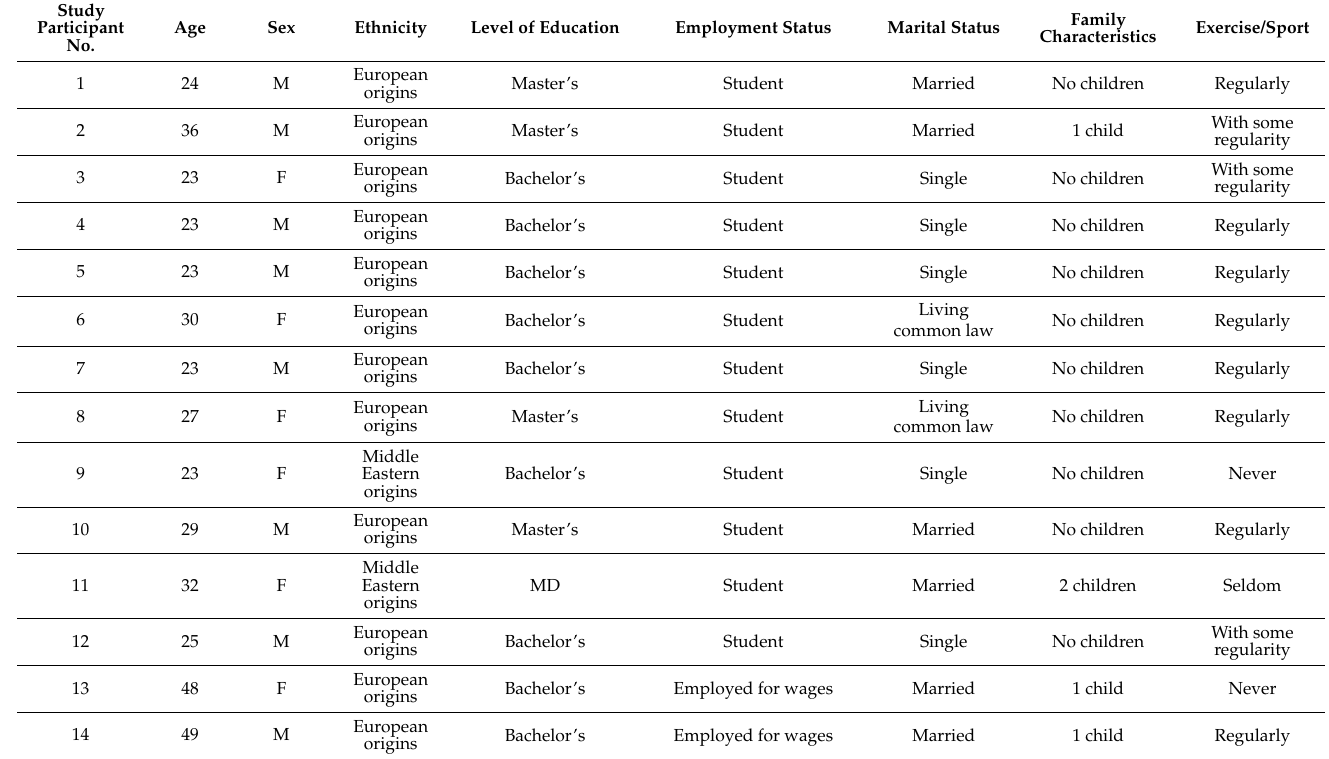
Table 1. Demographic characteristics of